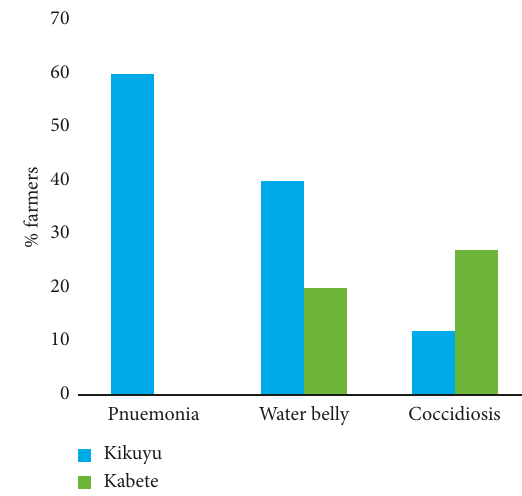
Figure 4: Diseases managed by farmers in Kikuyu and Kabete subcounties (%).